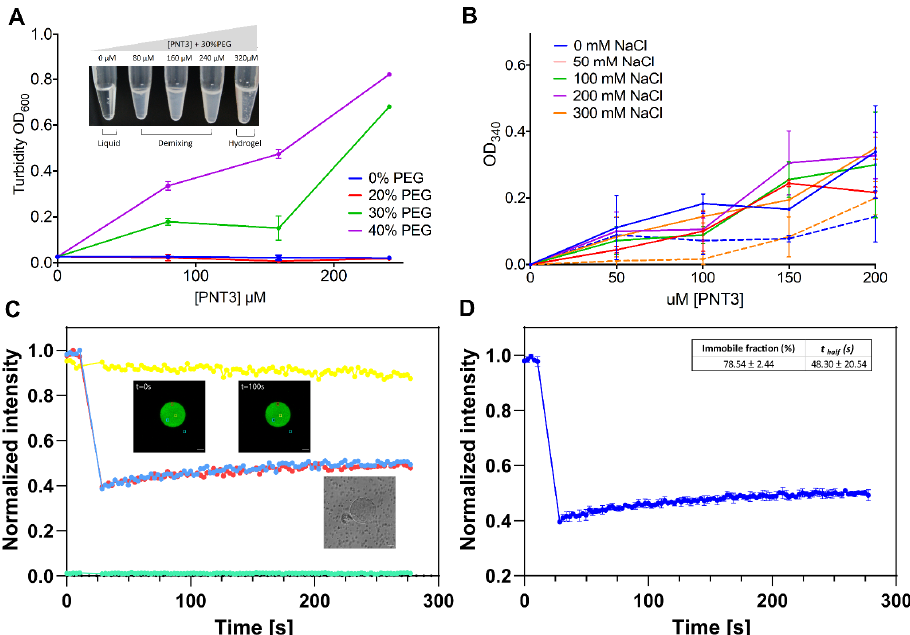
Figure 3. Phase-separation abilities of PNT3. ( A ) Turbidity measurements of PNT3 samples at different concentrations either in the absence or in the presence of increasing PEG 300 concentrations after 1 h of incubation at RT. ( B ) Aggregate formation in PNT3 samples at different concentrations either in the absence or in the presence of increasing concentrations of NaCl after 1 h of incubation at 37 °C (continuous lines) or at RT (dotted lines). ( C ) and ( D ) present the FRAP analysis of an Alexa-Fluor 488-labeled PNT3 sample at 100 nM after a one-week incubation at 37 °C. ( C ) Fluorescence recovery curves of two condensate (blue and red) and two control (yellow and green) regions. Insets: fluorescence images of condensate at t = 0 s and t = 100 s, and bright-field image of the condensate. Scale bars: 10 µm. ( D ) Fluorescence recovery curve of PNT3-AF488 condensates. Typical error bars represent the standard deviation (SD) of measurements on four different regions of the condensate, including the blue and red regions shown in panel C.